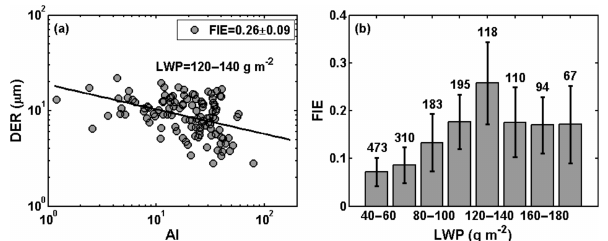
Figure 10. (a) Cloud droplet effective radius (DER) as a function of scattering aerosol index (AI) for a sample bin with a constant liquid water path (LWP) range of 120 to 140gm − 2 , and (b) the quanti- fied aerosol first indirect effect (FIE) for each LWP bin. Numbers above each bar in (b) are the number of samples that went into the calculation of the